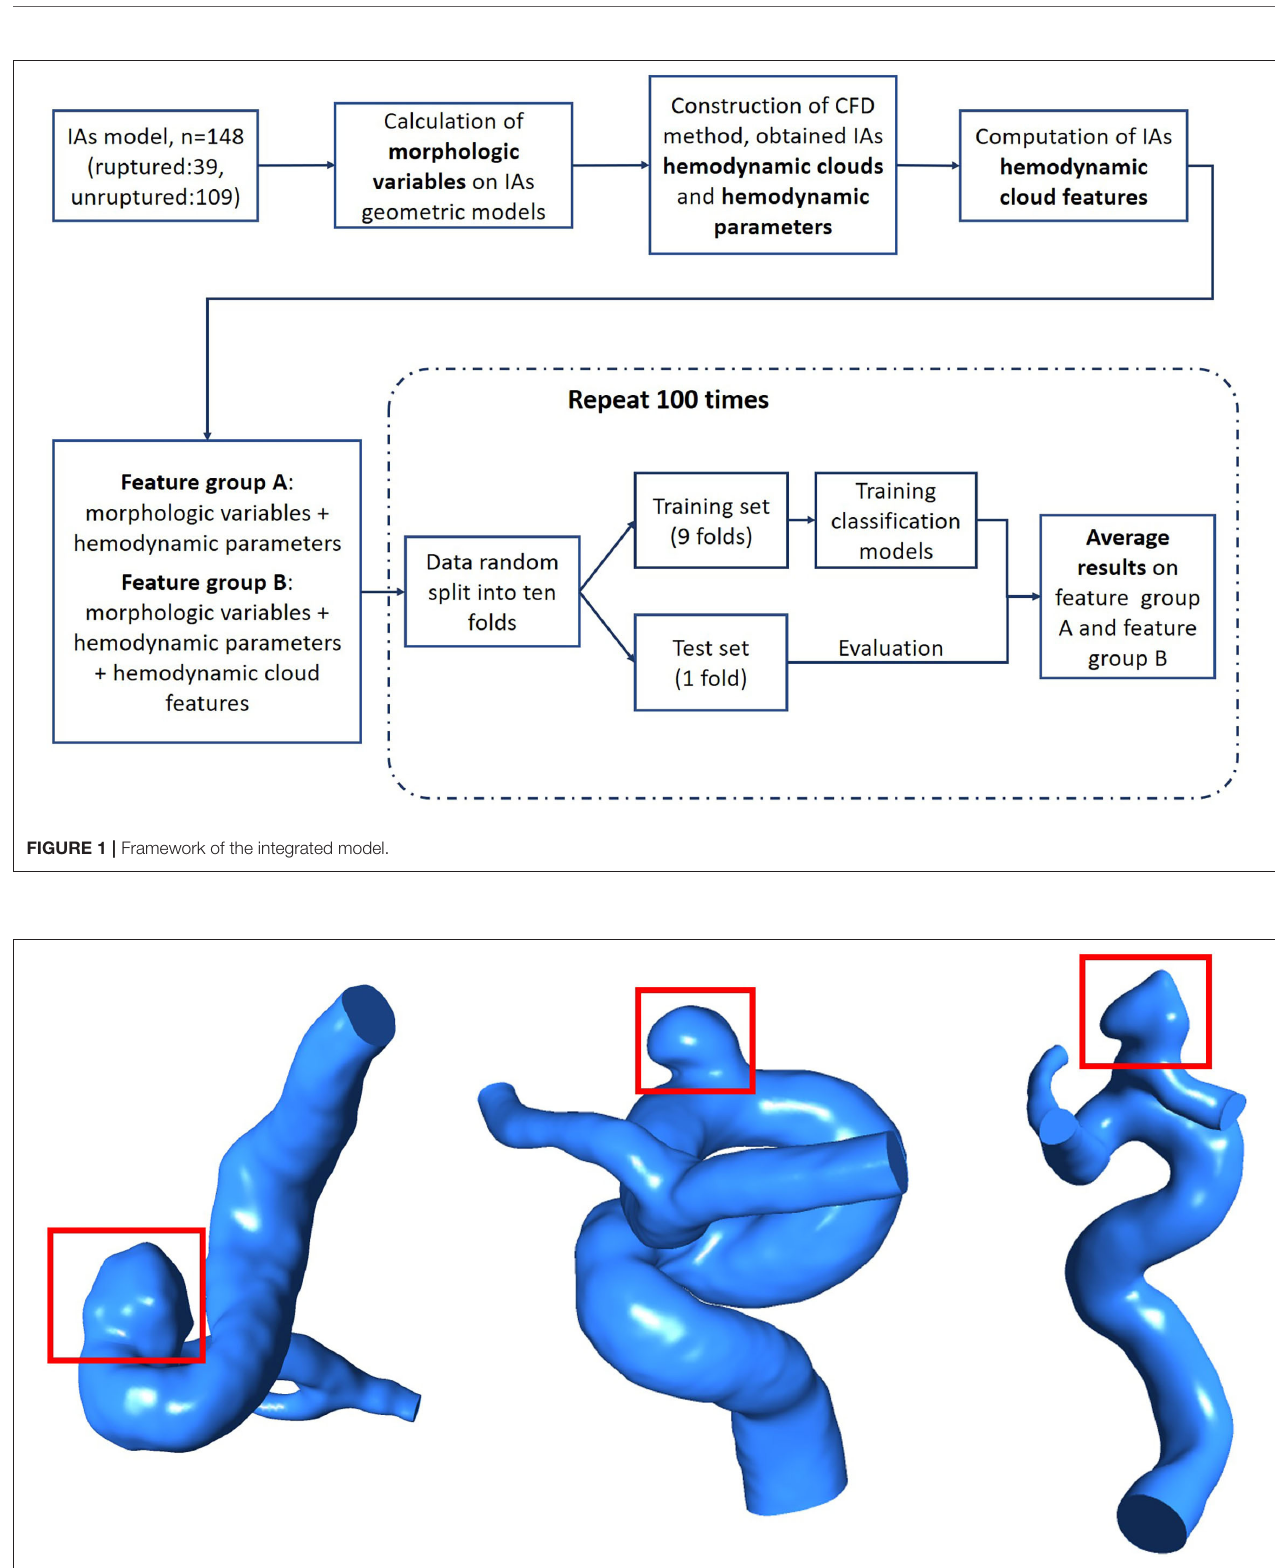
FIGURE 2 | IA models (the areas marked by red boxes are sacs of